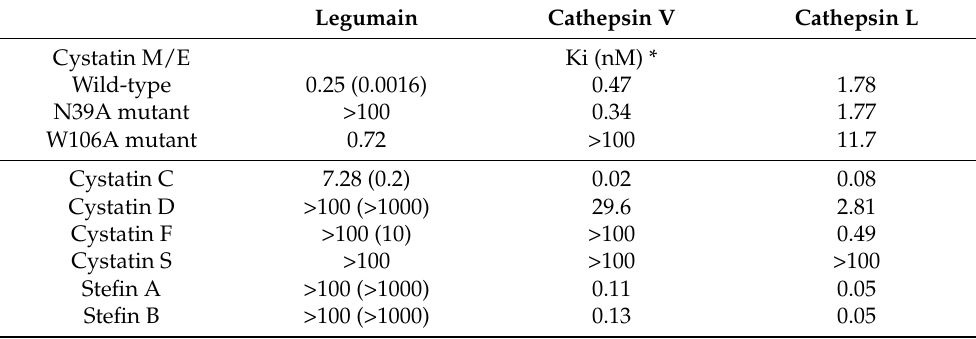
Table 1. Inhibitory constant (Ki) of human cystatins for human target proteases. Legumain Cathepsin V Cathepsin L Cystatin M/E Ki (nM) * Wild-type 0.25 (0.0016) 0.47 1.78 N39A mutant >100 0.34 1.77 W106A mutant 0.72 >100 11.7 Cystatin C 7.28 (0.2) 0.02 0.08 Cystatin D >100 (>1000) 29.6 2.81 Cystatin F >100 (10) >100 0.49 Cystatin S >100 >100 >100 Stefin A >100 (>1000) 0.11 0.05 Stefin B >100 (>1000) 0.13 0.05 For the sake of homogeneity with the body text, cystatin C numbering is used. * From [35]. In bracket: pig legumain